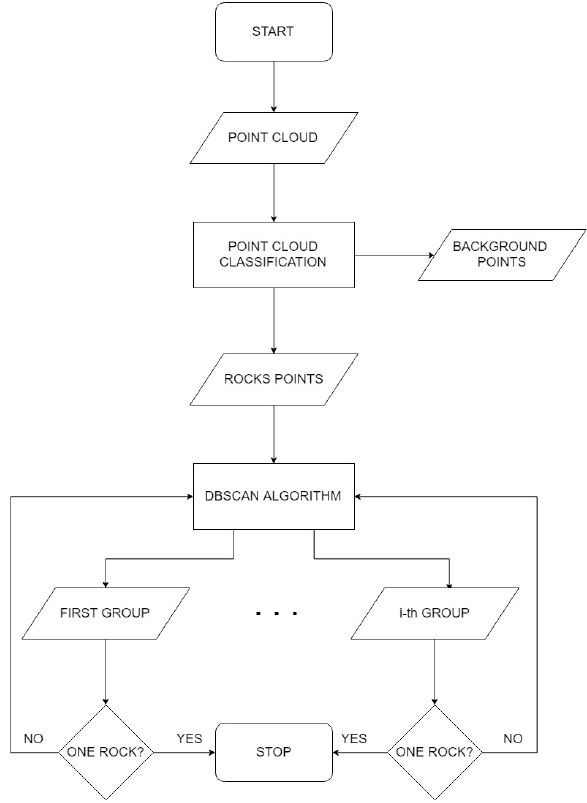
Figure 2. The flow chart of proposed